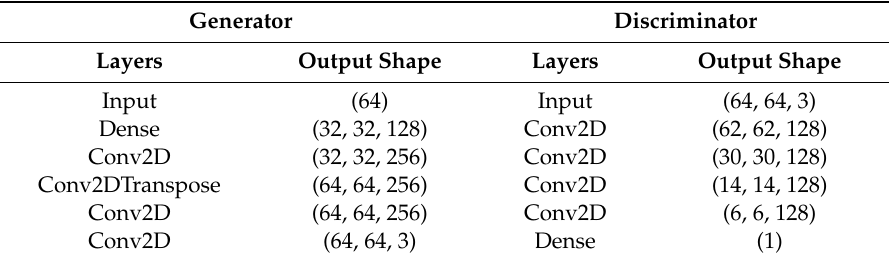
Table 2. The generator and discriminator in GAN.